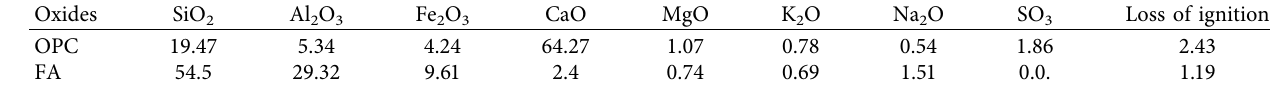
Table 1: Chemical compositions of cement and fly ash.